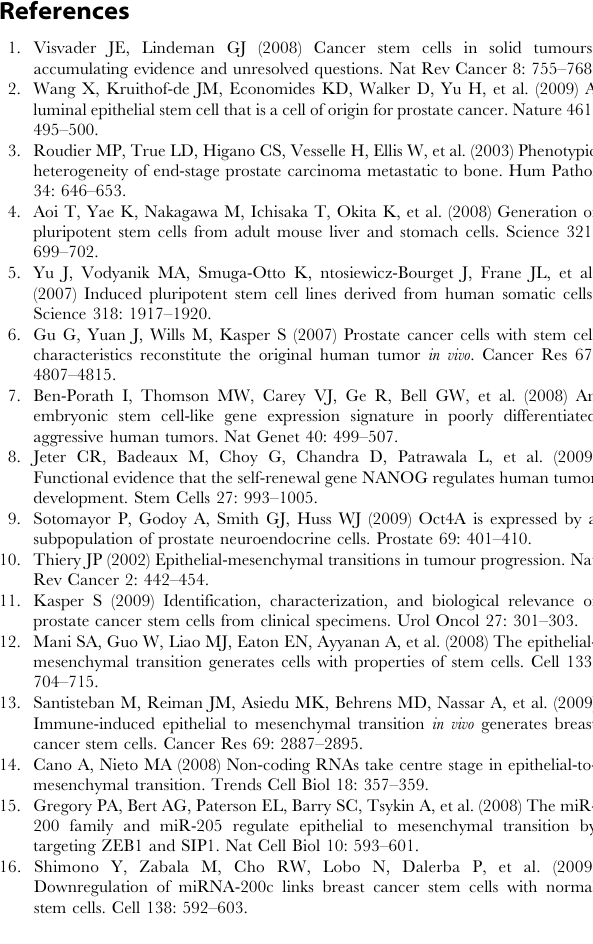
Table S3 The levels of miR-200 and let-7 family in PC3 Neo and PC3 PDGF-D cells. Table S4 Primer sequences used in real time